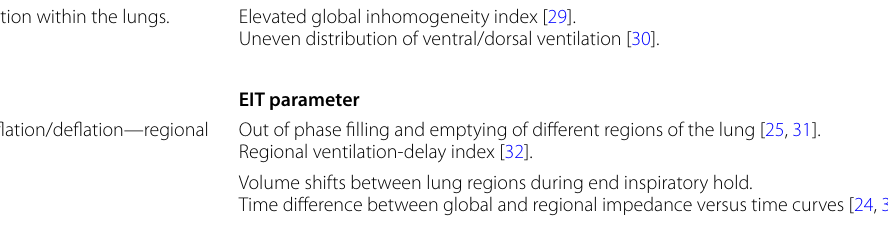
Out of phase filling and emptying of different regions of the lung [25, 31]. Regional ventilation-delay index [32].